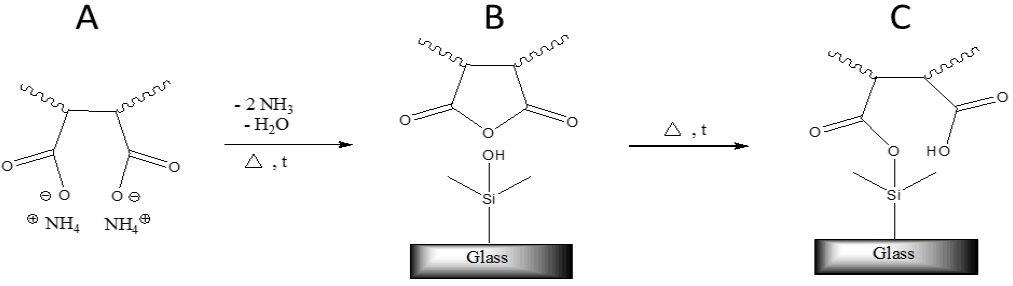
Figure 1. The chemical bounding of the terpolymer coated from aqueous ammonia solution with the glass surface.